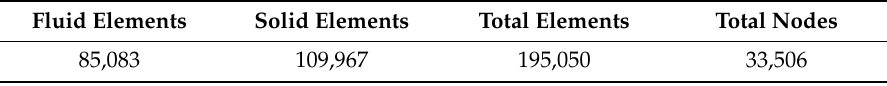
Table 2. Finite-element mesh sizes used in this simulation. Figure 3. ( a ) Geometry mesh, ( b ) zoom of the mesh of the inlet/outlet surface. Fluid Elements Solid